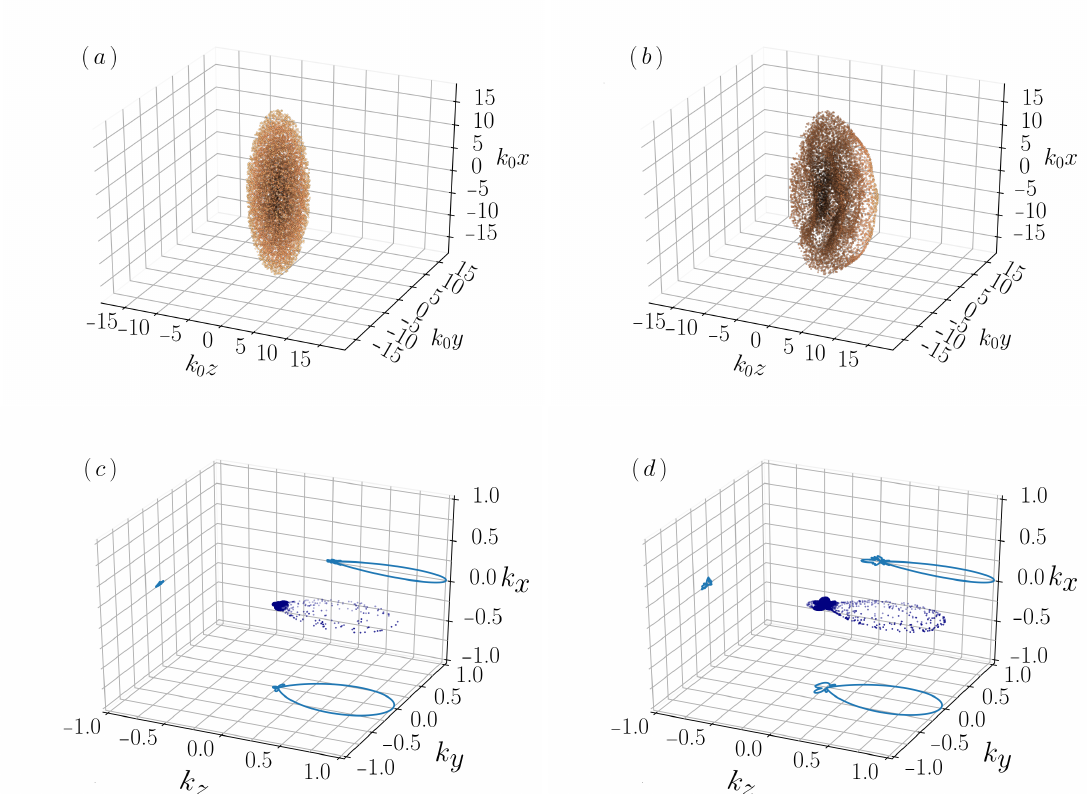
Figure 4. Collective scattering and pattern formation from an ellipsoidal 3D atomic cloud irradiated with a pump field propagating perpendicular to its major axis and linearly polarized along the y axis: ( a ) Shows the initial random atomic density distribution with N = 10 4 . ( b ) Depicts the density grating formation due to collective scattering at t = 0.173 ω − 1 r . The corresponding bunching factors | M ( k , t ) | for both time instants are displayed as a function of k (in k 0 units) in ( c ), for the initial state, and in ( d ), for t = 0.173 ω − 1 r